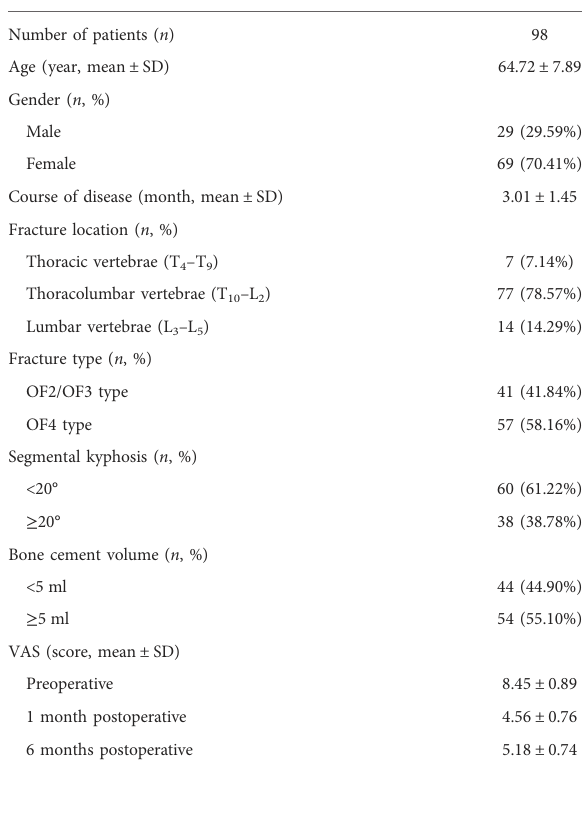
TABLE 1 Clinical characteristics of the included